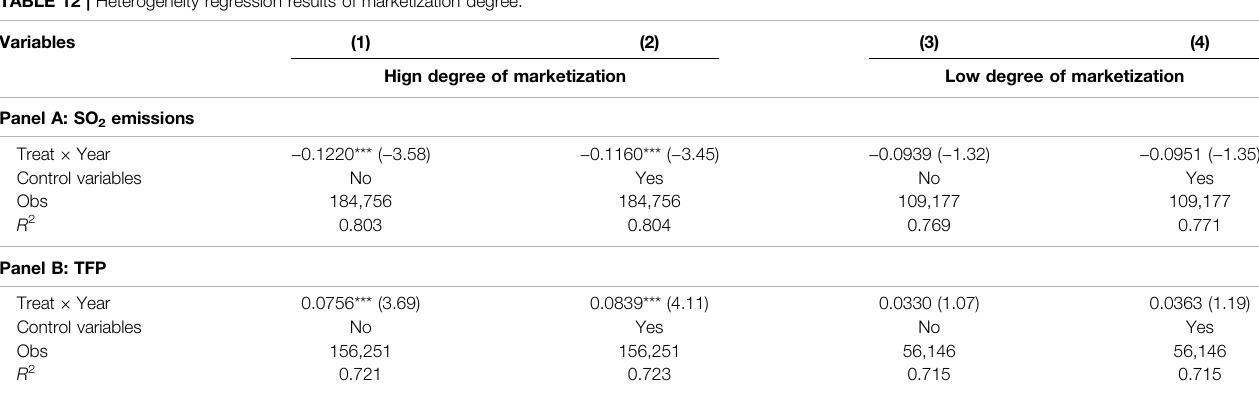
TABLE 12 | Heterogeneity regression results of marketization